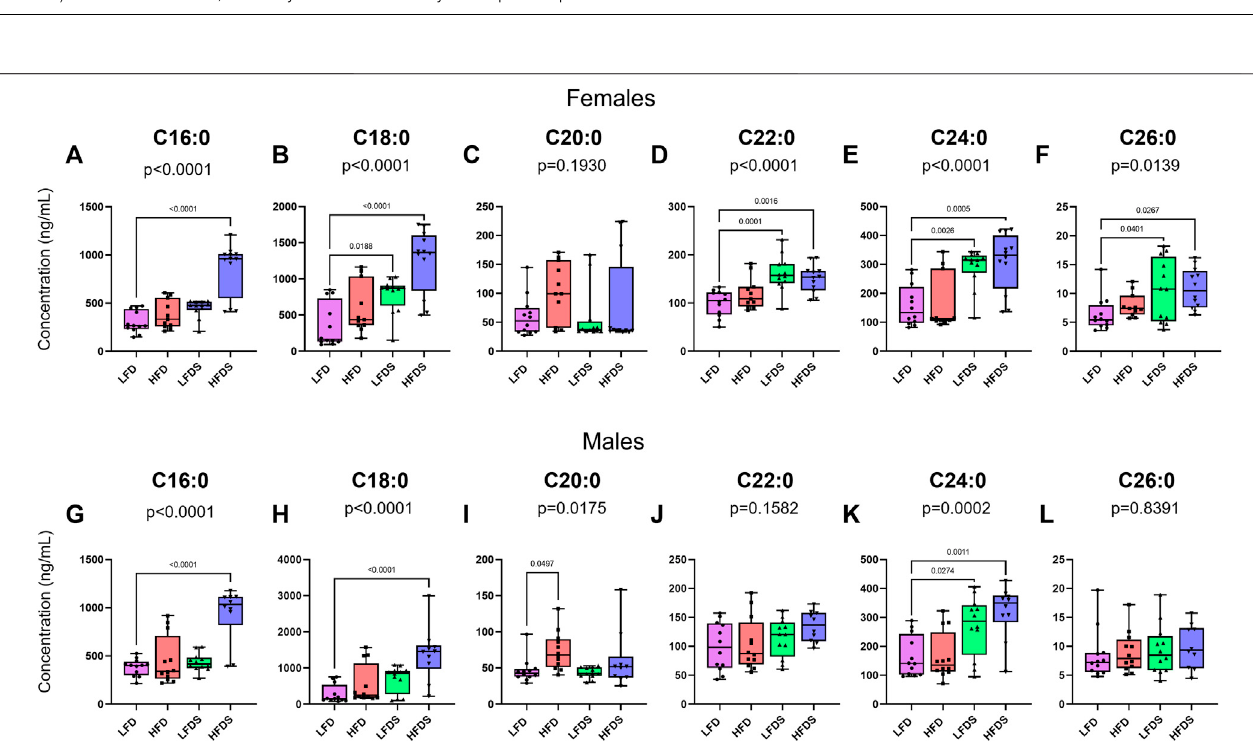
FIGURE 3 | Ceramides in blood serum after HFD and/or STU stress. (A – F) Long-chain ceramides in blood serum from female rat groups. (G – L) Long-chain ceramidesinserumofmalerats.Datarepresentedasmean±SEM.Femalesamplesizes:LFD=12,HFD=11,LFDS=12,andHFDS=12.Malesamplesizes:LFD=12, HFD = 12, LFDS = 12, and HFDS = 10. Statistic used, One-way ANOVA with Tukey ’ s multiple comparison test.